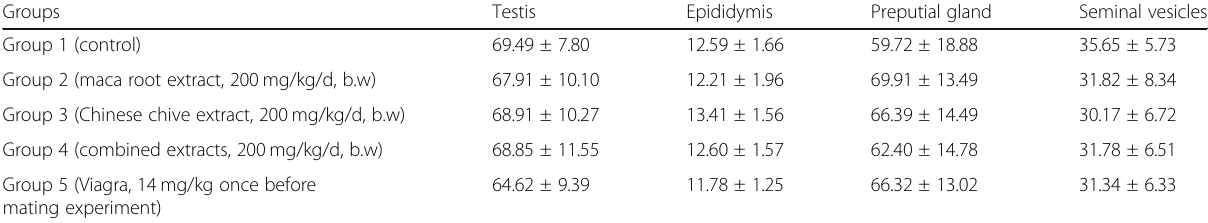
Table 3 Effects of maca root extract, Chinese chive extract and combined extracts on genital indexes (mg/10 g) (mean ± SD)